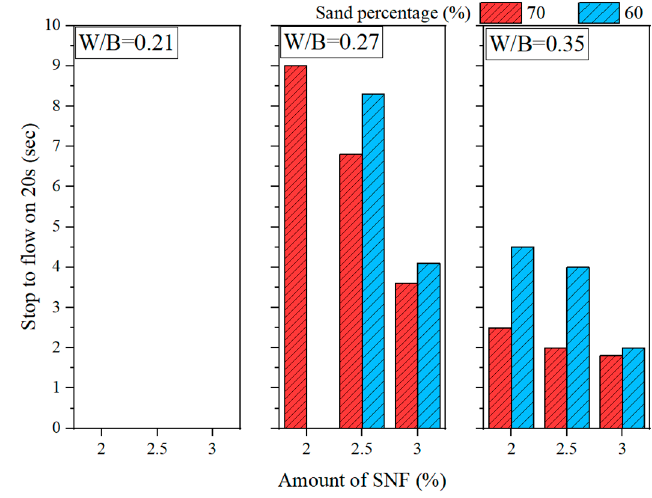
Figure 2. The time required for the flow of SNF to 20 cm.